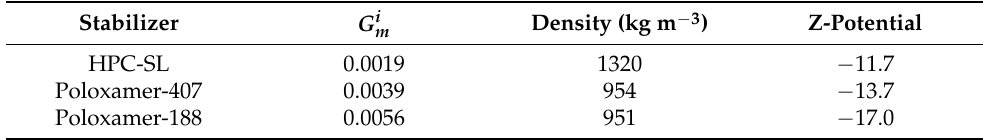
Figure 2. Saft- γ -Mie stabilizer candidates, material properties results ( a ) Poloxamers’ densities ( b ) Poloxamers’ heat capacities ( c ) HPC-SL density ( d ) HPC-SL heat capacity as a function of temperature. Table 4. Interfacial Gibbs energy and material properties